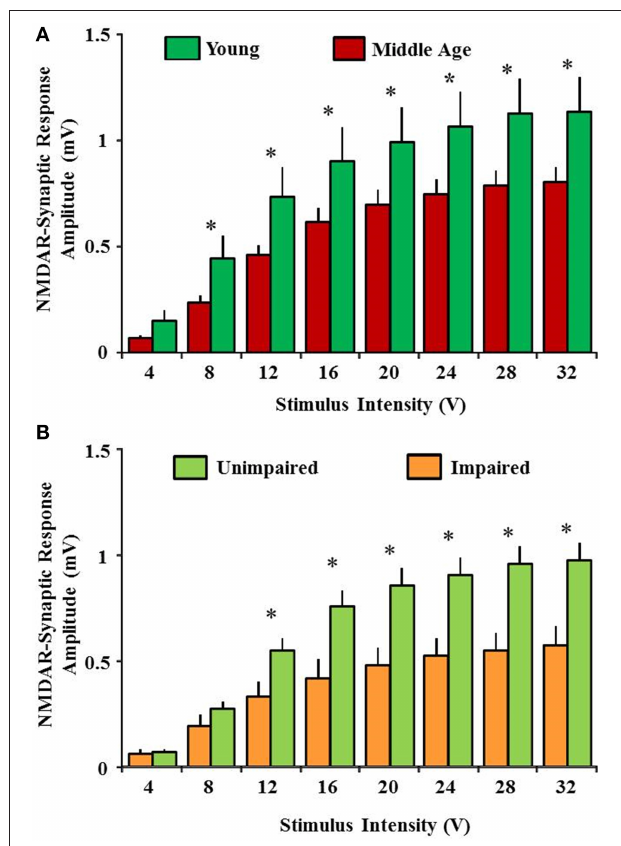
FIGURE 2 | Reduced NMDA receptor-mediated synaptic response with advanced age is associated with impaired cognitive function. (A) Input-output curves for the NMDA receptor-mediated synaptic potentials recorded from CA3-CA1 hippocampal synapse in slices obtained from young (green) and middle age (red) animals. An age-related decrease in the synaptic response was observed. (B) A significant decrease in NMDA receptor-mediated synaptic response was observed in impaired animals (yellow) when compared with unimpaired (lime green). Cognitive performance was assessed by using Morris swim task. The NMDA receptor-mediated component of synaptic transmission (NMDAR-fEPSP) was obtained by incubating slices in artificial cerebrospinal fluid containing low Mg 2 + (0.5mM), 6,7-dinitroquinoxaline-2,3-dione (30 µ M), and picrotoxin (10 µ M). Input-output curves for the NMDAR-fEPSP amplitude (mV) were constructed for increasing stimulation intensities. * indicates significant